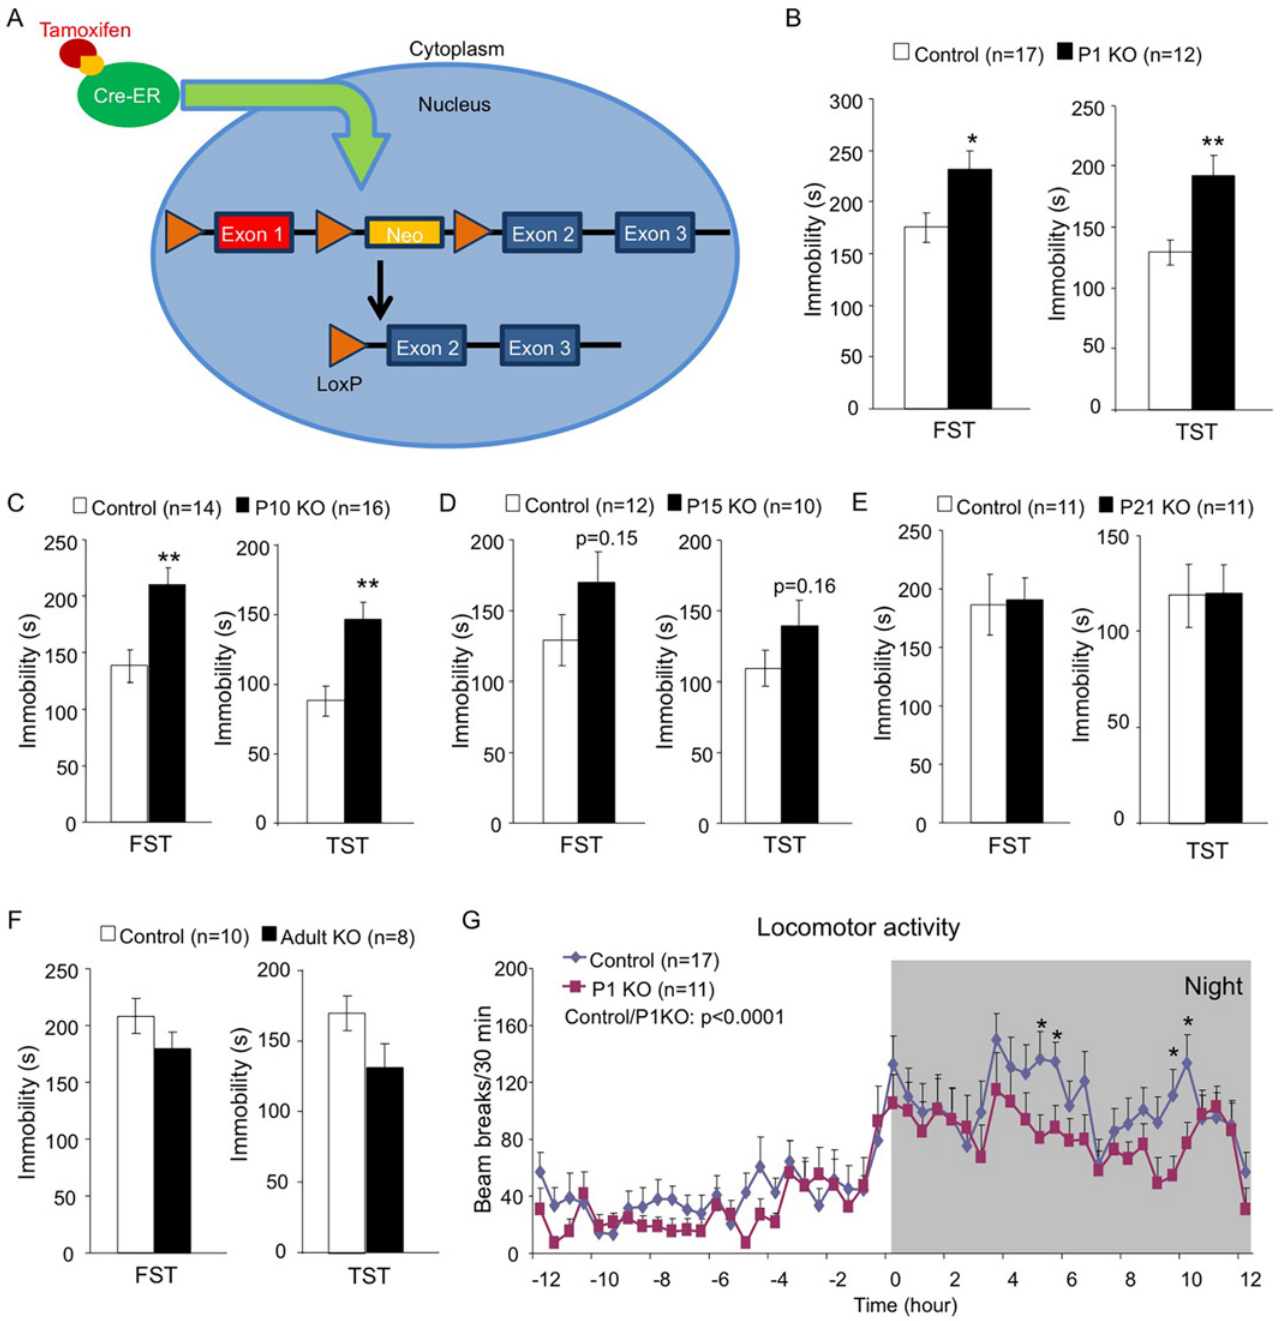
Fig 1. Early postnatal depletion of Hap1 leads to depressive-like behavior in adult mice. ( A ) A schematic of the TM-inducible Cre/loxP system to delete Hap1 in mice. ( B-F ) Forced swim and tail suspension tests (FST and TST) were performed at 3 months of age for Hap1 P1 (B, P1 KO), P10 (C, P10 KO), P15 (D, P15 KO) and P21 (E, P21 KO) KO mice, and 4 months of age for mice that had Hap1 gene deleted at 2 months old (F, adult KO). Note that early postnatal Hap1 depletion, but not late postnatal or adult depletion, led to increased immobility in the FST and TST. ( G ) Locomotor activities of 2-month-old Hap1 P1 KO and control mice were monitored and recorded for 24 h. The KO mice showed a general reduction in locomotor activity. All error bars represent SEM. * p < 0.05, ** p < 0.01. In (G), two-way (genotype and time) ANOVA and post hoc tests were performed to determine statistical significance.